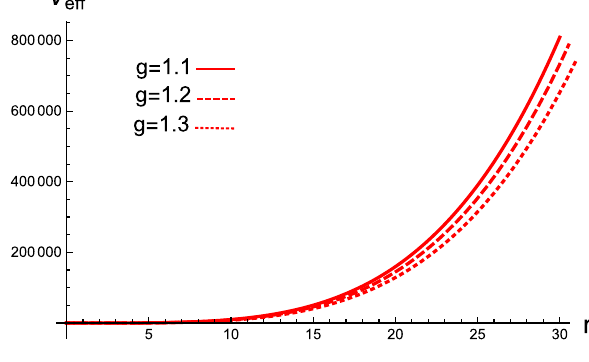
Fig. 3 Plot of the effective potential with respect to r for ϑ = 0 . 2